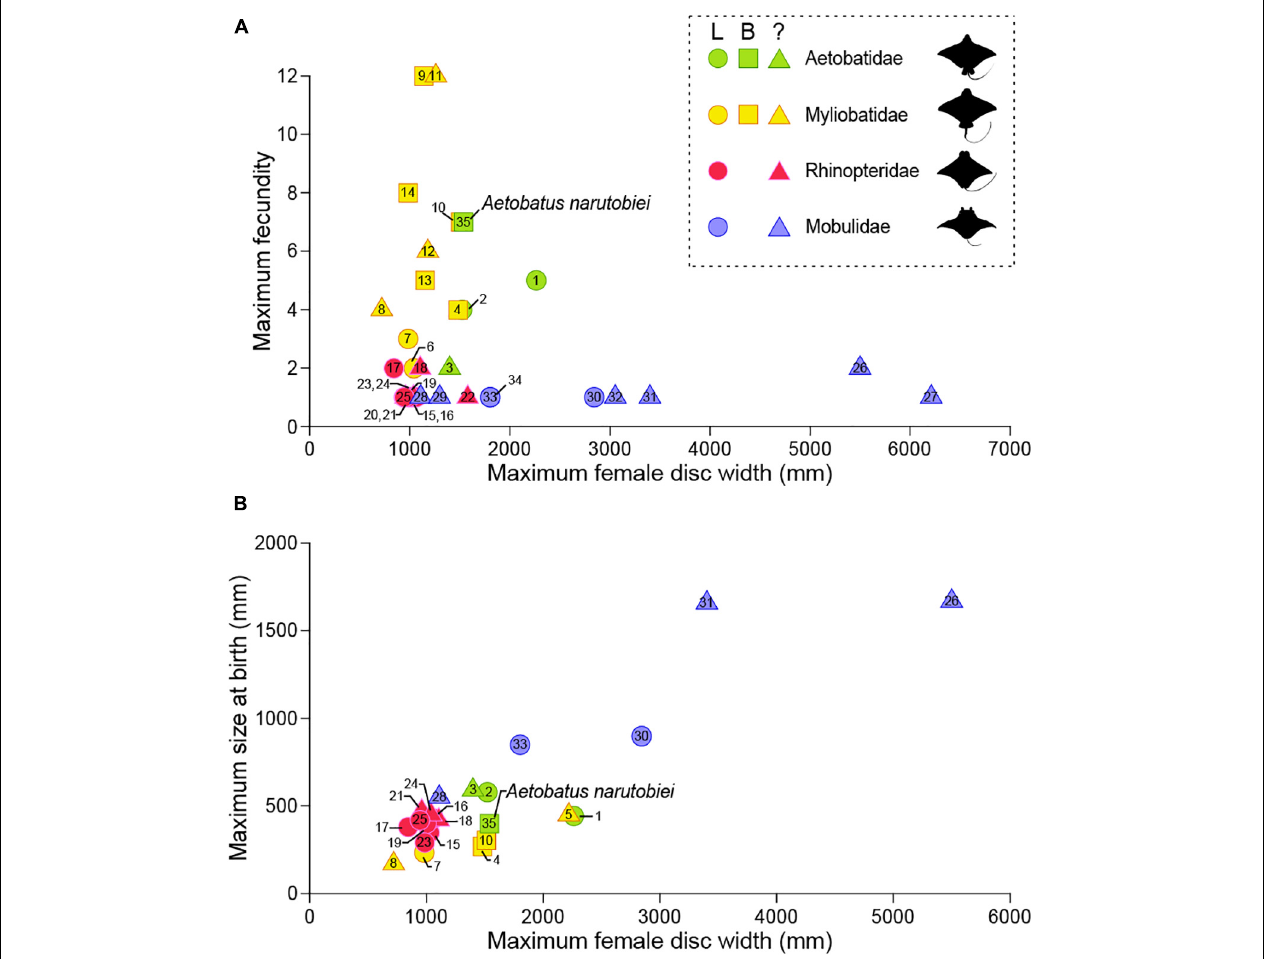
FIGURE 14 | Variability in the number of functional uteri compared to (A) fecundity and (B) maximum size at birth for subfamily Myliobatinae. Rays with two functional uteri are represented by squares, circles are shown for rays that have a single (left) functional uterus, and triangles are shown for species that have not been described. Aetobatus narinari : 1 (Tagliafico et al., 2012) and 2 (Swider et al., 2017); Aetobatus ocellatus : 3 (Uchida et al., 1990); Aetomylaeus bovinus : 4 (Seck et al., 2002) and 5 (Dulˇci´c et al., 2008); Aetomylaeus maculatus : 6 (Devadoss, 1982); Aetomylaeus nichofii : 7 (Devadoss, 1998) and 8 (Last and Stevens,